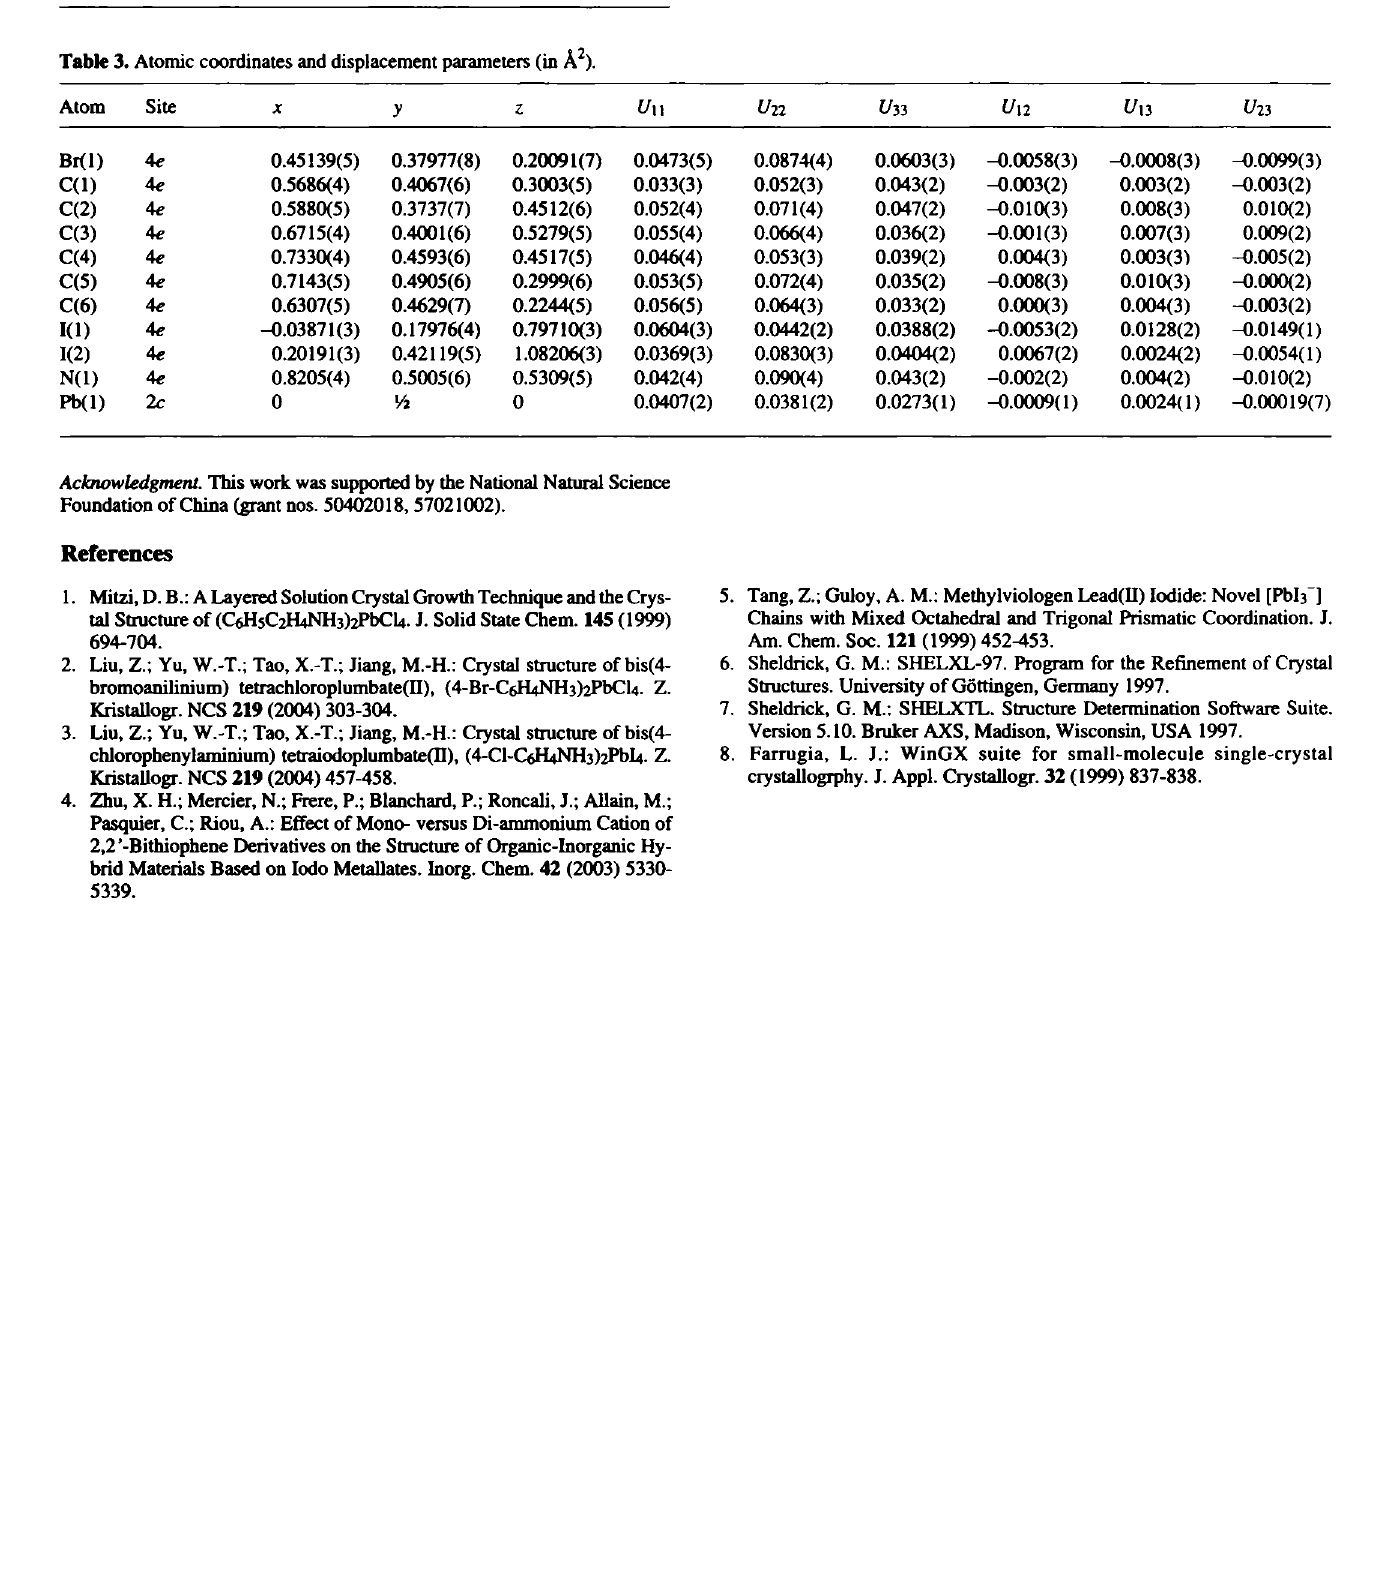
Table 3. Atomic coordinates and displacement parameters (in Â 2